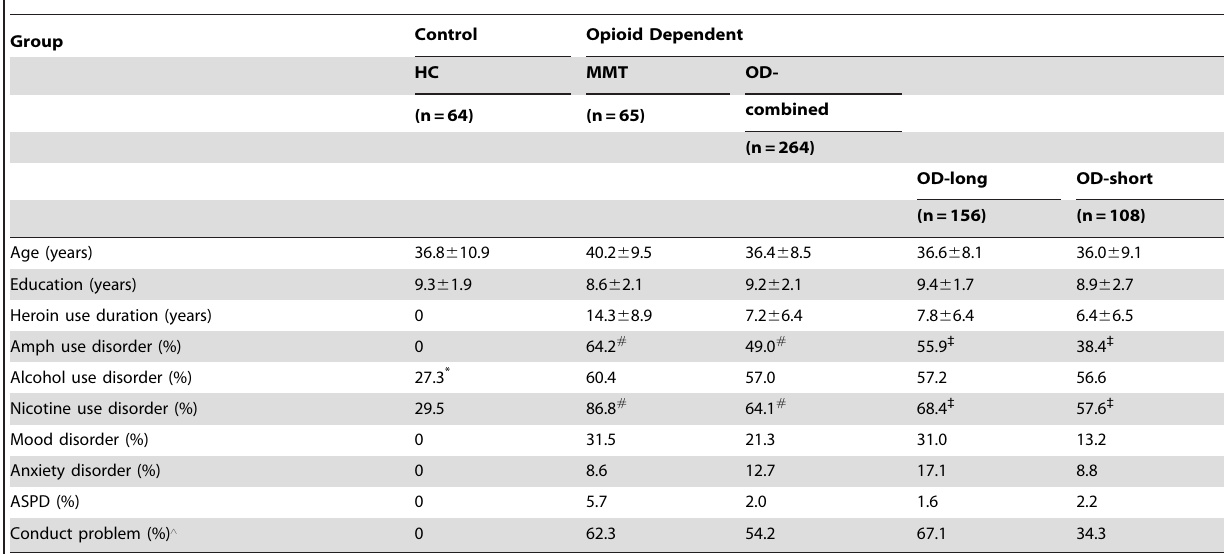
Table 1. Demographics and clinical characteristics